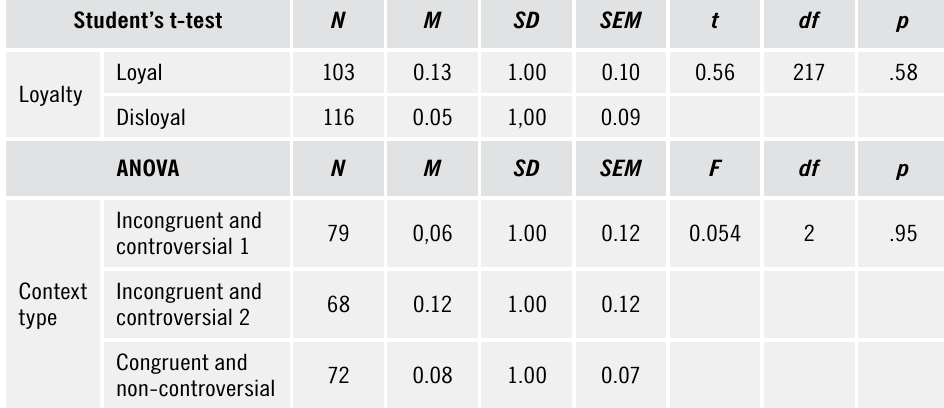
Table 6. Change in sponsorship-vignette awareness by independent variables Student’s